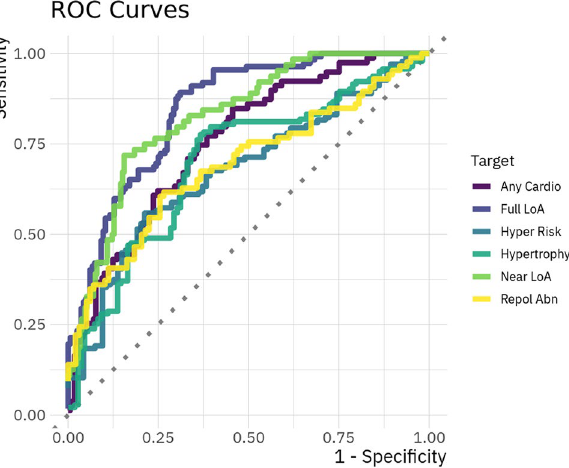
Figure 3. ROC curves for selected classification models. Shown are the ROC curves of six classifiers. Abbreviations: LoA - Loss of Ambulation; Repol Abn - repolarisation